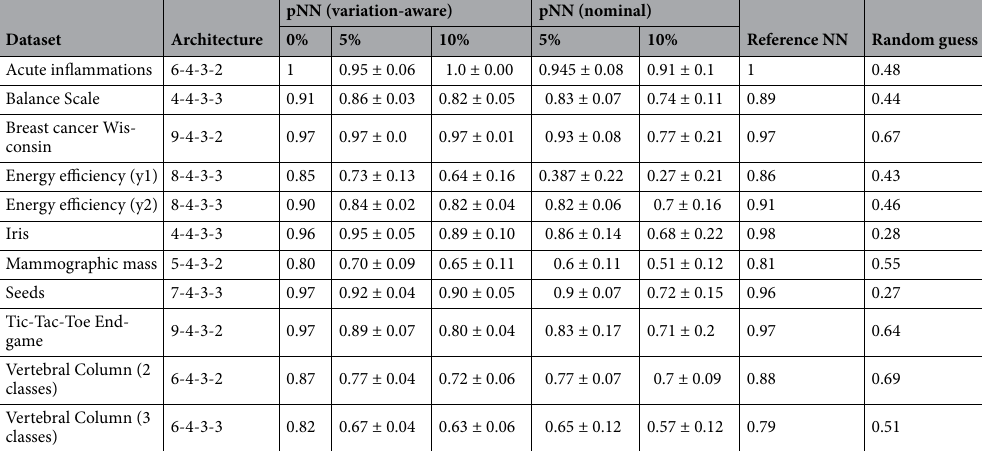
Table 3. The evaluation table of the experiments. Architecture with neurons/layer. The experiments were carried out as described in Sect. 5 of the supplementary material. Each number represents test measuring- aware accuracy (see supplementary material). The results under variation are based on 100 samples and the mean and the standard deviation of the Measuring-aware accuracy are reported. The reported random guess baseline indicates the accuracy for always predicting the most frequent class in the training